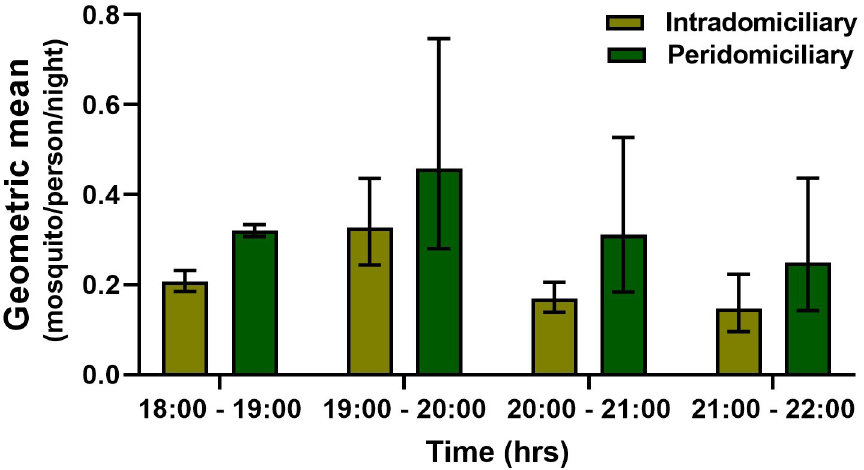
Fig 3. Biting activity per hour of Anopheles (Nys . ) albimanus in five communities of the Darien region, between March and November 2016 (geometric mean ± 95% confidence interval).